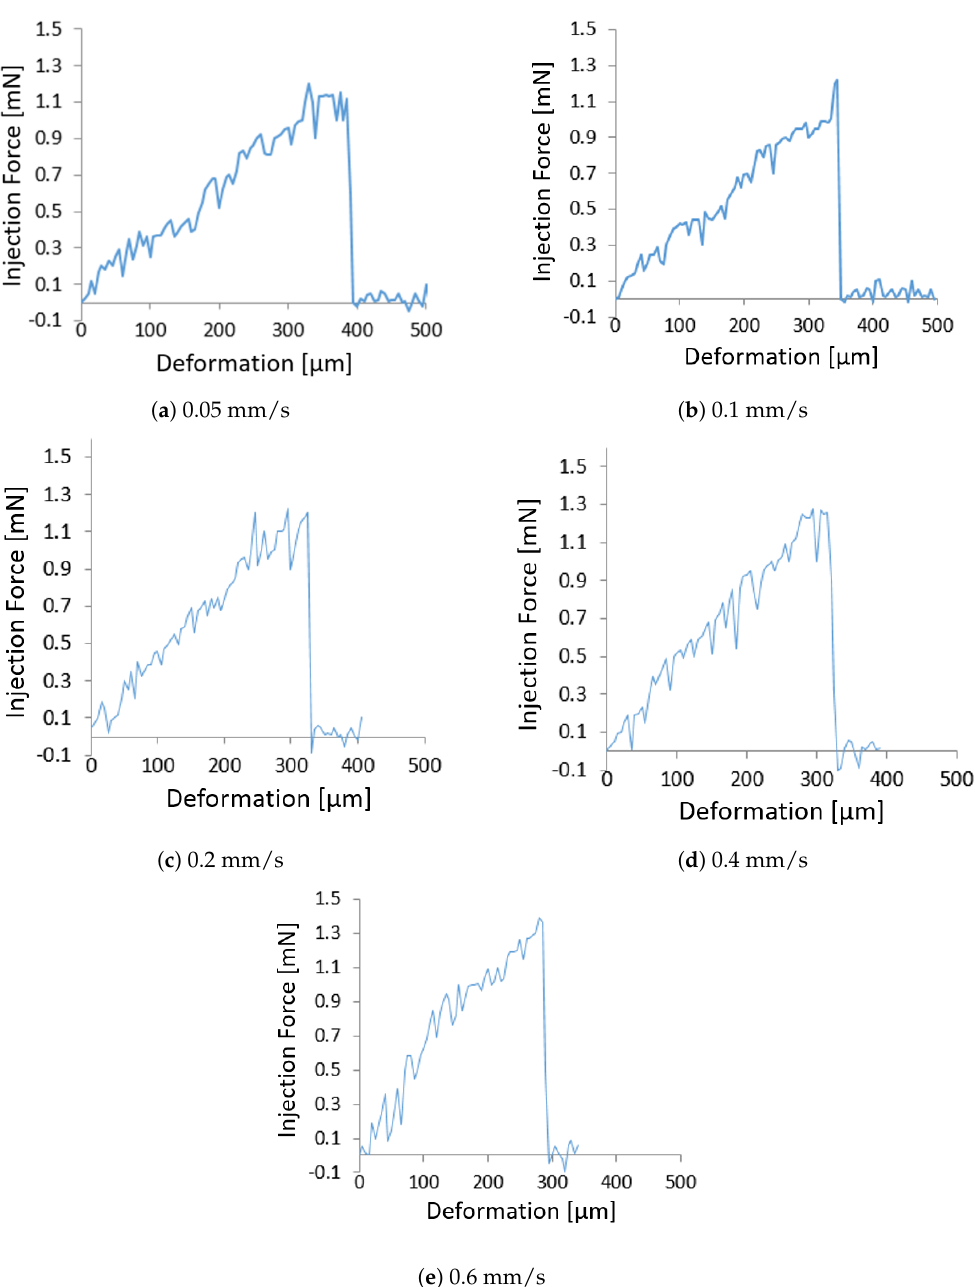
Figure 7. Experimental results in terms of force-deformation for various injection